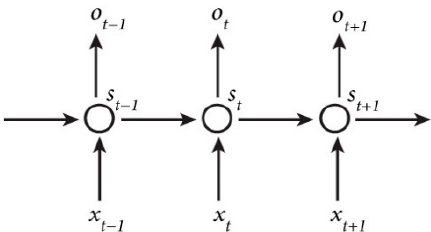
Figure 1. Unfolding in time of the computation of RNN network.